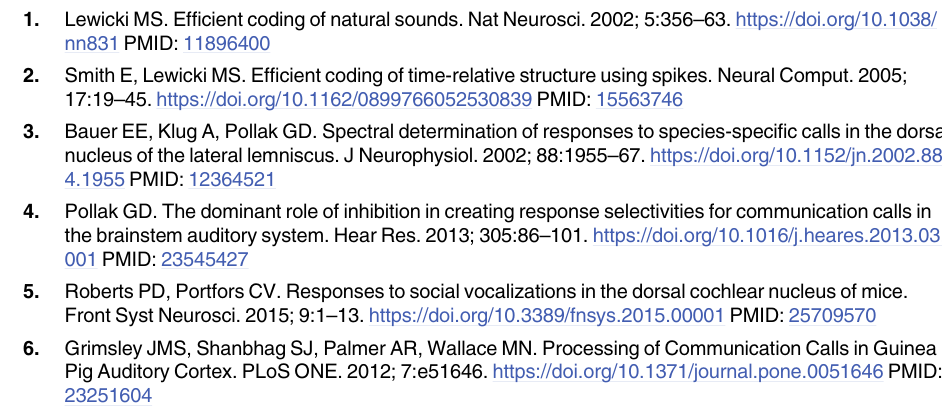
S6 Data. Data underlying Fig 6. (XLSX) S7 Data. Data underlying Fig 7. (XLSX) S8 Data. Data underlying Fig 8. (XLSX) S9 Data. Data underlying S1